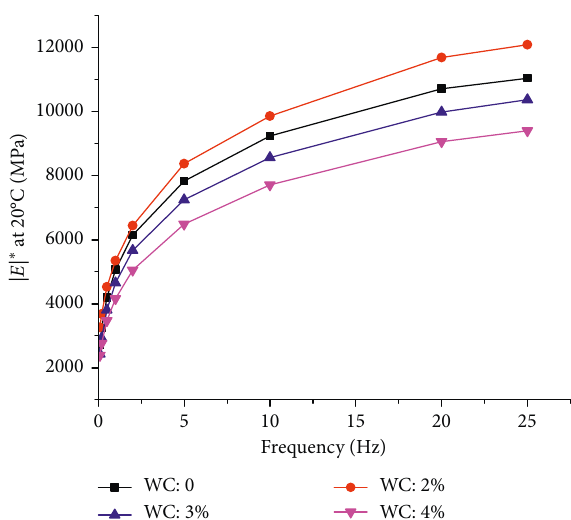
Figure 11: SBS#AC-20-type normal-temperature dynamic modulus.